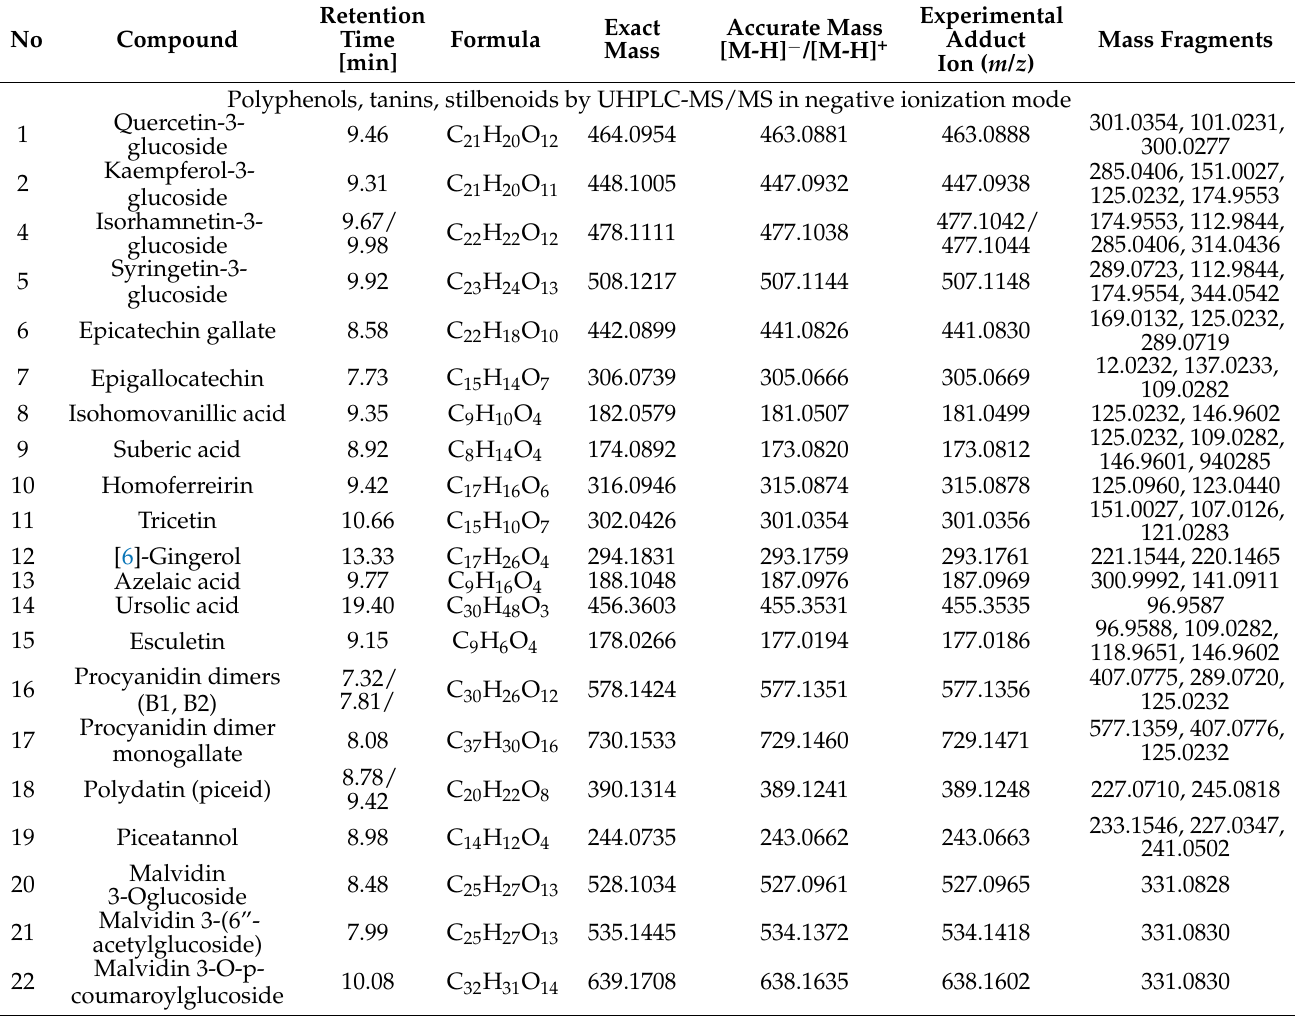
Table 2. Identification of bioactive phytochemical compounds (polyphenols, tannins, stilbenoids) and amino acids in grape pomace extracts by UHPLC-Q-Exactive high-accuracy analysis of deproto- nated precursors and fragment ions of specific components combined with data processing using Compound Discoverer